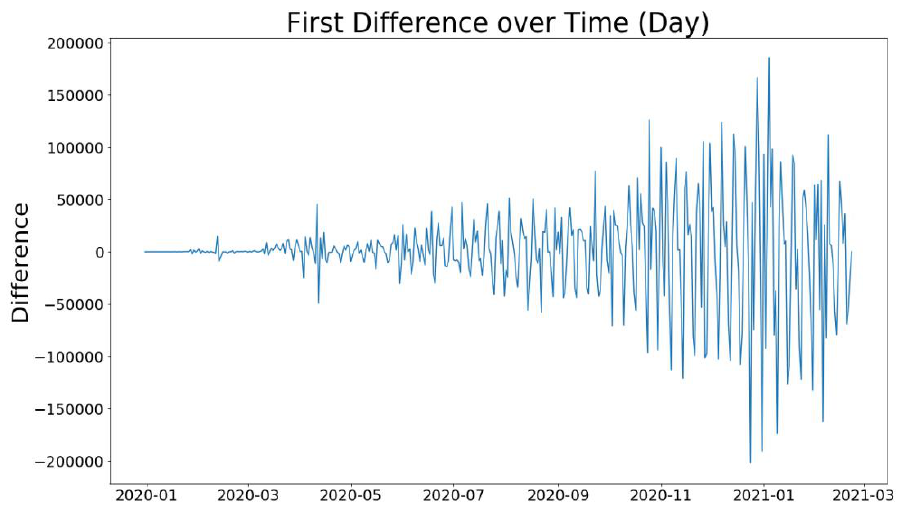
Figure 2. The first difference between daily confirmed cases of COVID-19: World